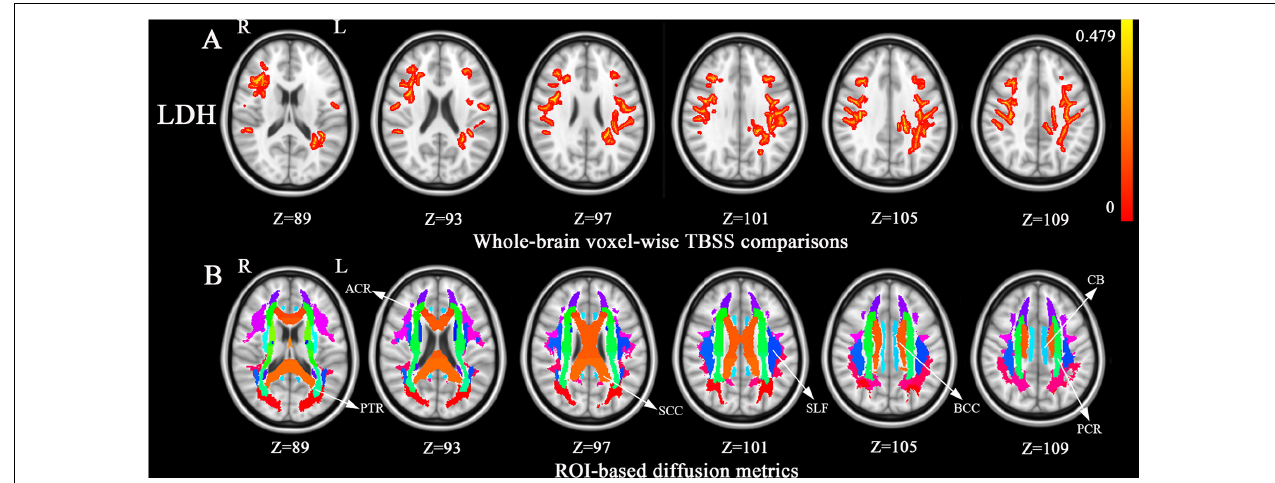
FIGURE 1 | Tract-based spatial statistics (TBSS) analysis of white matter diffusion. (A) Differences in local diffusion homogeneity (LDH) between the patient group and the HC group. Orange (thickened for better visibility) represents increased LDH in the patient group when compared to the HC group (family-wise error [FWE], P < 0.05). (B) , The Johns Hopkins University white matter atlas was overlaid on the normalized T1-weighted images in the standard ICBM-DTI-81 space. Colored regions indicate major white matter tracts exhibiting differences between the patient and HC groups. Color bar denotes the t -values. Abbreviations: ACR, anterior corona radiate; BCC, the body of corpus callosum; CB, cingulum bundle; FA, fractional anisotropy; HC, healthy control; L, left; PCR, posterior corona radiata; PTR, posterior thalamic radiata; R, right; ROI, region of regions; SCC, the splenium of corpus callosum; SLF, superior longitudinal fasciculus.